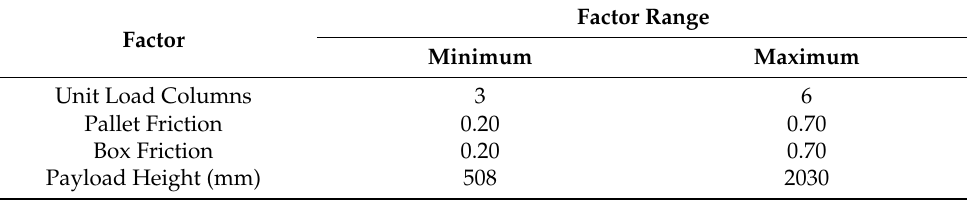
Table 3. Factor limiting ranges for each significant variable in the Gaussian Process Model.